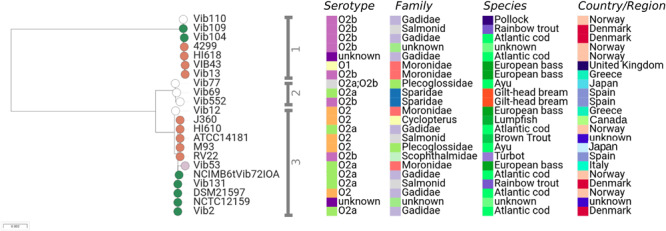
Tree constructed based on LPS biosynthesis genomic island (for the 22 isolates in which this region is present). Mapping to this segment (14,281-bp long) in VIB43 was used to build the tree. The tree distinguished three variants of this region, indicated by grey brackets. Variant 1 is associated with serotype O2b and is found in isolates from L2i, L2ii, L4 and isolate Vib10. Variant 2 is found in three distinct isolates Vib77, Vib69 and Vib552. Variant 3 is associated with multiple serotypes, and is found in isolates from lineages L2, L4, L6, and isolate VIB12.